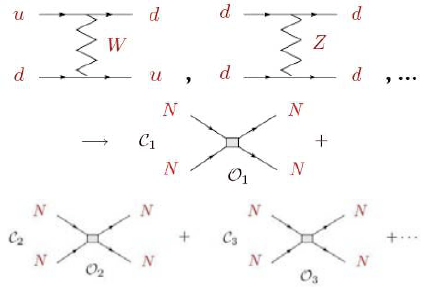
Fig. 3. Quark-gluon-weak-boson PV interactions mapped onto EFT. N is either p or n. The are unknown parameters. Each box C represents an operator.